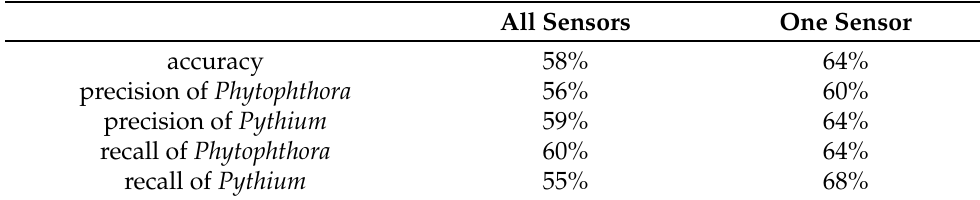
Table 3. Performance of classification models with logistic regression trained with features extracted from responses of all sensors and only the single sensor TGS 2603. Cross-validation in groups determined by the day of measurements. Binary target classification of sample categories of acorns infected with Phytophthora and Pythium